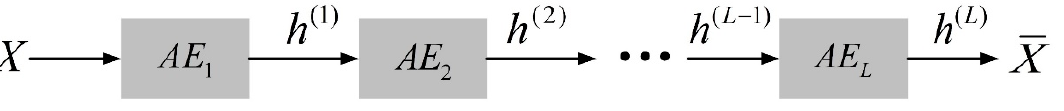
Figure 3. Schematic diagram of the principle of stacked autoencoders with L autoencoders.